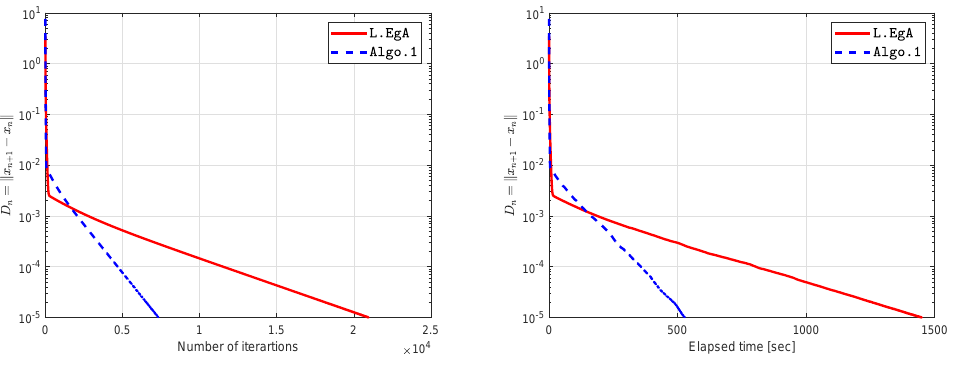
Figure 4. Example 1 while tolerance is 0.00001. Table 3. Figures 1–4 numerical